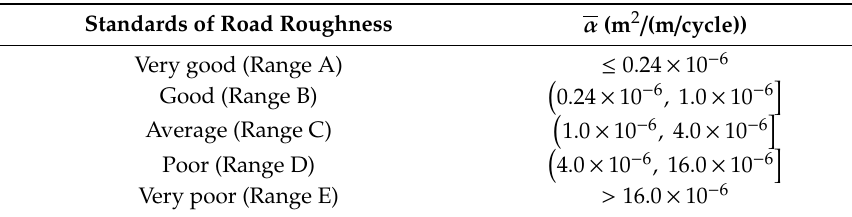
Table 2. Definition of coe ffi cient term α